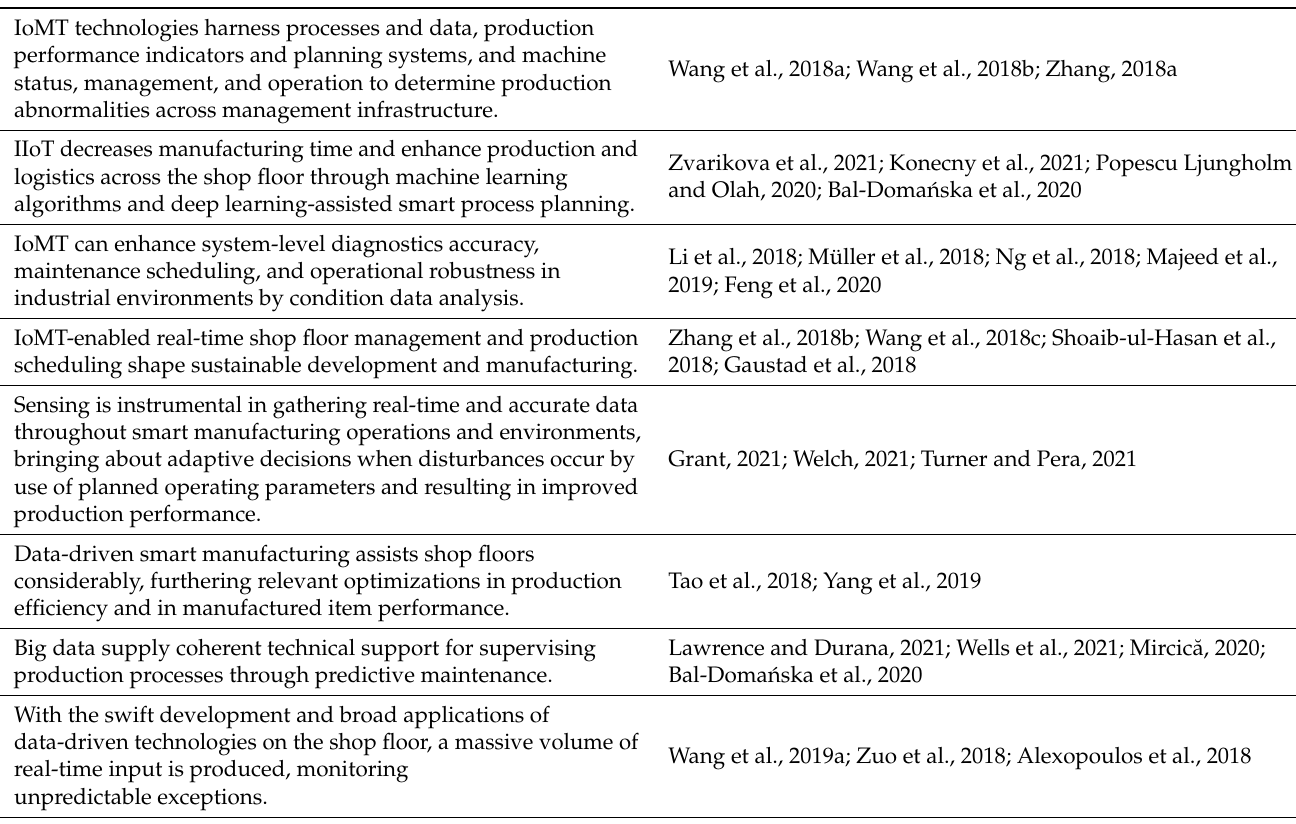
Table 2. Synopsis of evidence regarding analyzed topics and descriptive outcomes (research